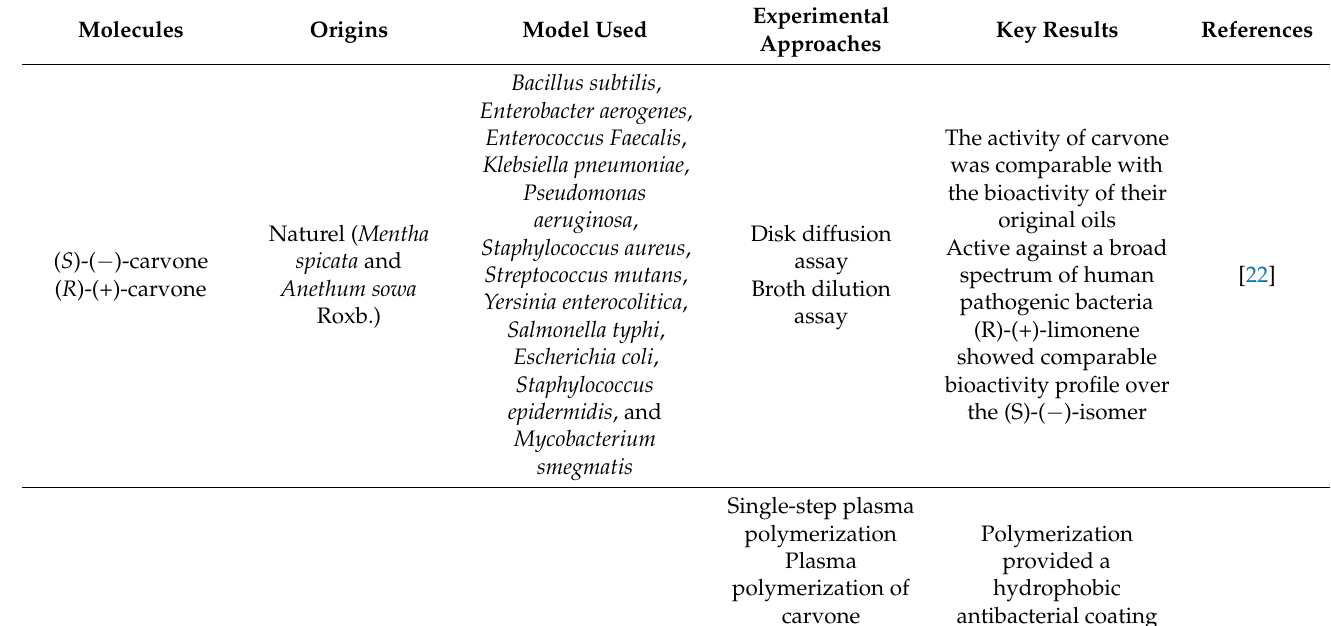
Table 4. Antibacterial activity of